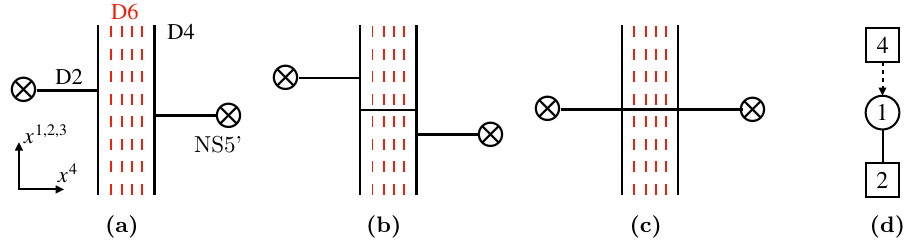
Figure 8. (a): the NS5’-branes and the D2-branes insert a product ’t Hooft operator with total charge B = − e 1 + e 2 . (b): we add a D2-brane between the two D4-branes; it represents a smooth monopole. (c): the new D2-brane reconnects with the other D2-branes to form a single D2-brane that only end on NS5’-branes. The system realizes the sector with v = 0 , where the magnetic charge is screened completely. (d): the N = (0 , 4) quiver diagram for the SQM that lives on the D2-brane in